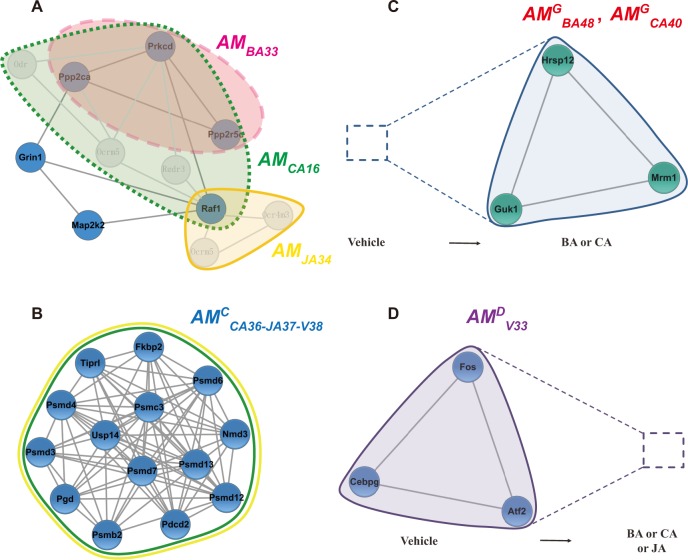
Examples of AMs, CAMs, GAMs, and DAMs.(A) AM
BA33- CA16- JA34. The pink dashed area, green dotted area, area in the yellow solid line indicate AMBA33, AMCA16, AMJA34, respectively. Blue nodes and dark gray edges represent AMV21. (B) AMCCA36-JA37-V37. AMCA36 and AMJA37 (represented by green and yellow circles) were completely overlapped with AMV38. (C) AMGBA48-CA40. Green nodes and dark gray edges denote AMBA48 or AMCA40, and the blue dashed square indicates that the module did not appear in the vehicle group. (D) AMDV33. Blue nodes and dark gray edges denote AMV33, and the purple dashed square indicates that the AM did not appear in the BA, CA or JA group.